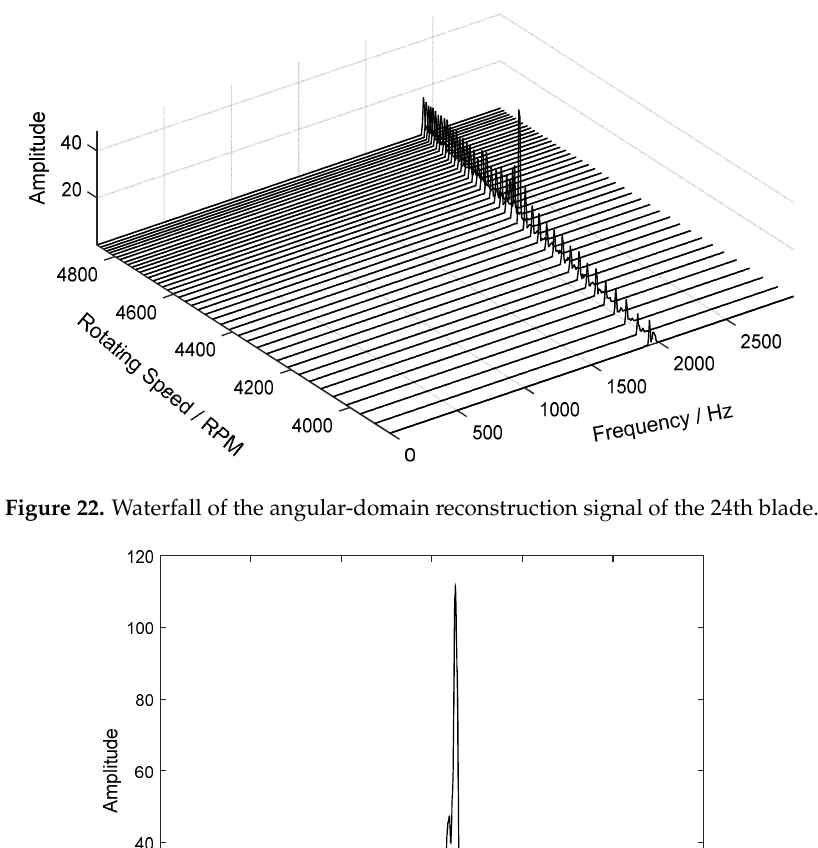
Figure 21. Time-varying order spectrum of the angular-domain reconstruction signal of the 24th blade.